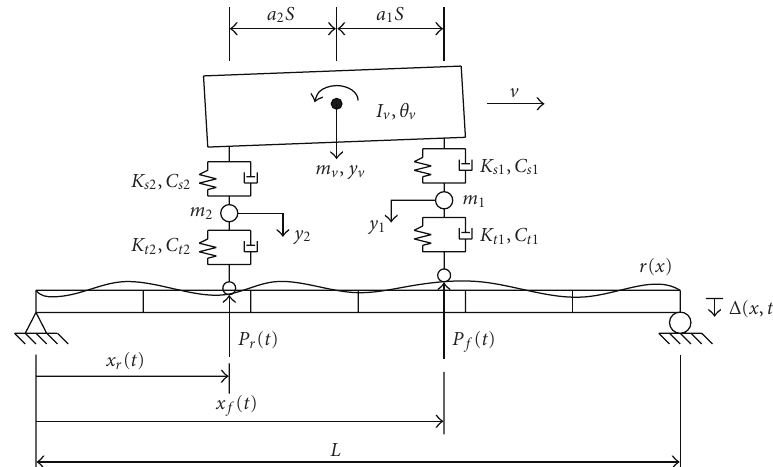
Figure 1: Vehicle and bridge WIM